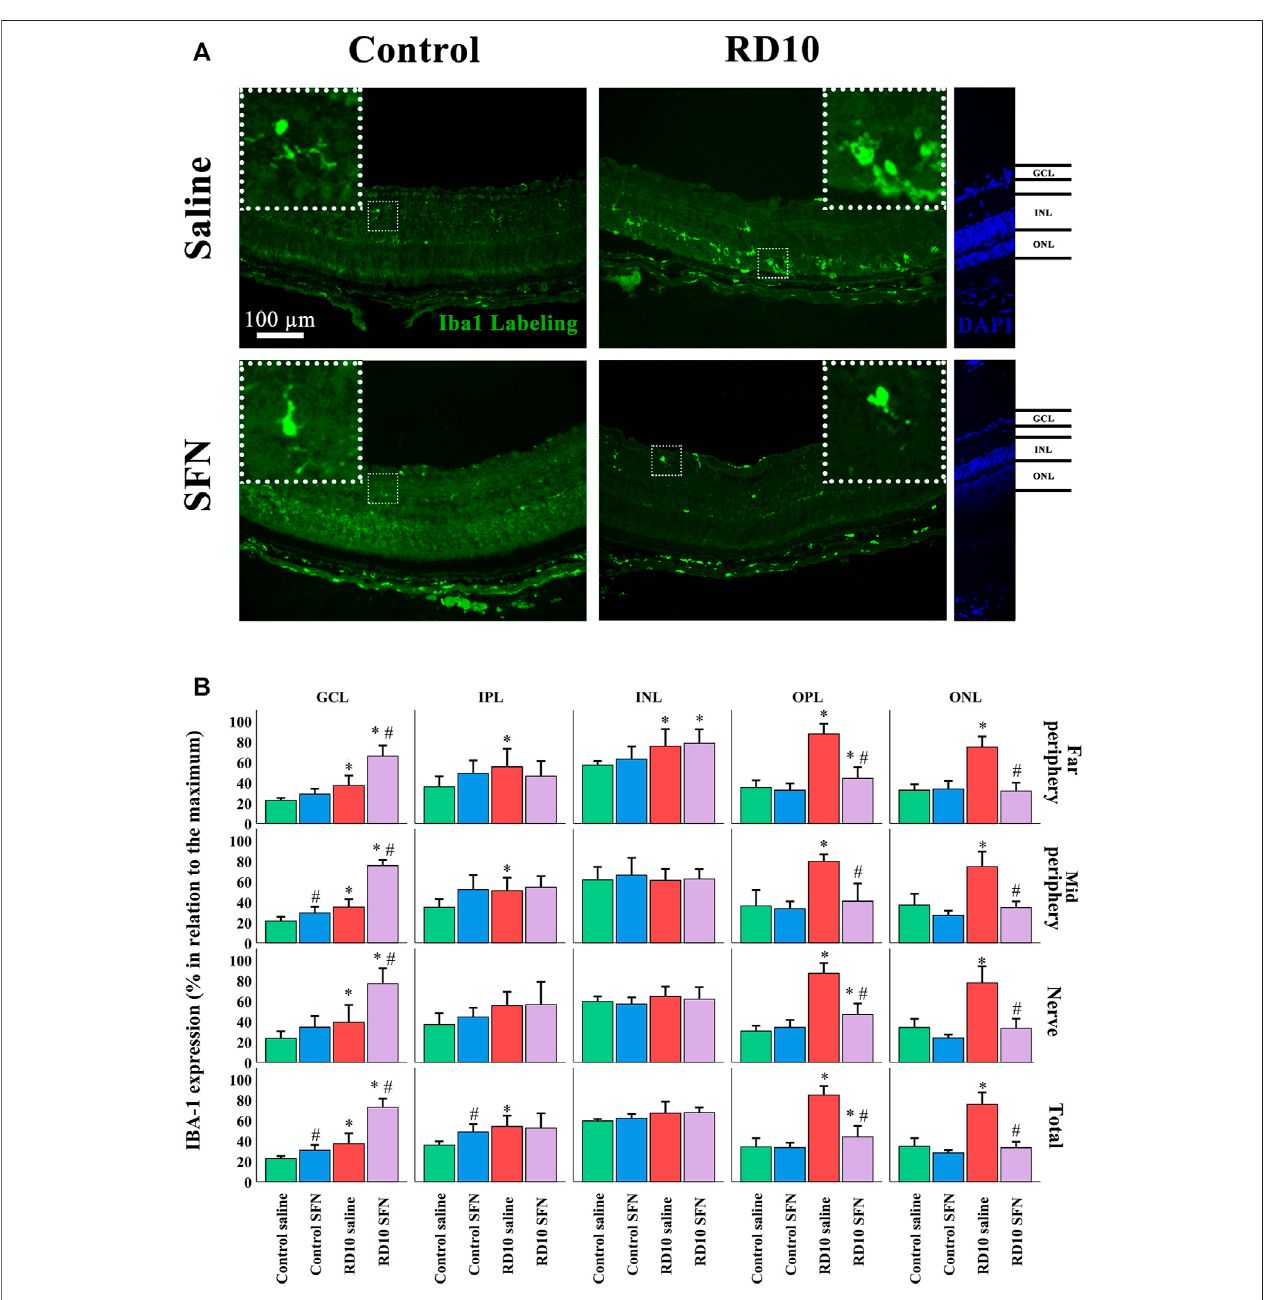
FIGURE 5 | Microglia phenotype analysis (A) Nerve region images of Iba1 immuno fl uorescence of the different groups in the experiment. (B) Iba1 cell percentage. *Differencesbetween ControlSaline vs. RD10Saline or ControlSFN vs.RD10 SFN( p -value < 0.05) #Differences betweenControlSaline vs.ControlSFNor RD10Saline vs. RD10 SFN ( p -value <